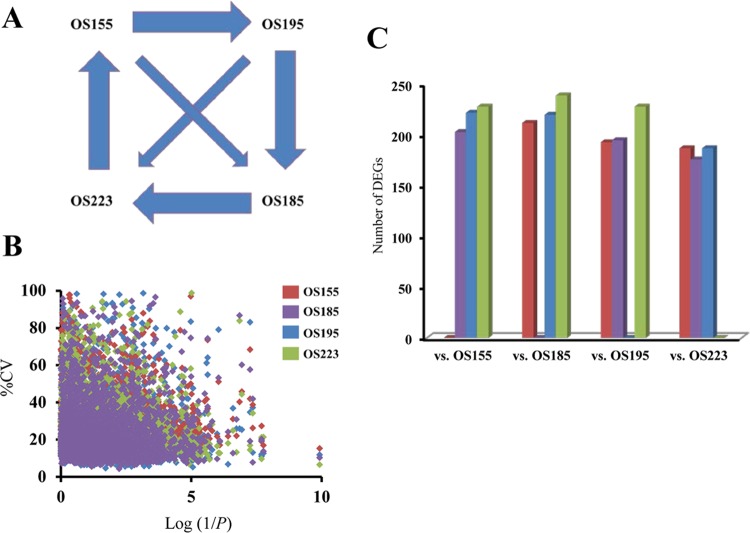
Microarray hybridization scheme and differentially expressed gene (DEG) profiles. Microarray hybridization loop design for all possible pairwise comparisons. Each arrow represents one strain-strain pairwise comparison, including 6 replicate hybridizations. (B) Experimental variation versus significance between strains. Experimental variation per gene (n = 3,937) per strain (n = 4) reported as %CV against log(1/P). P values were calculated from ANOVA results. (C) Number of DEGs per strain per pairwise comparison, including unique genes (n = 1,179). Unique genes were found at least once in at least one pairwise comparison (repeats not counted).